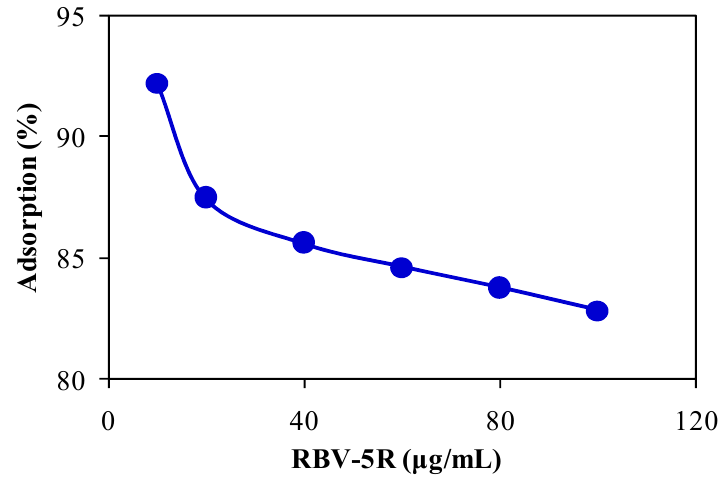
Figure 4. Effect of contact time on the biosorption of RBV-5R using SCB at 20 µg/mL RBV-5R, pH 6, 0.15 g SCB.